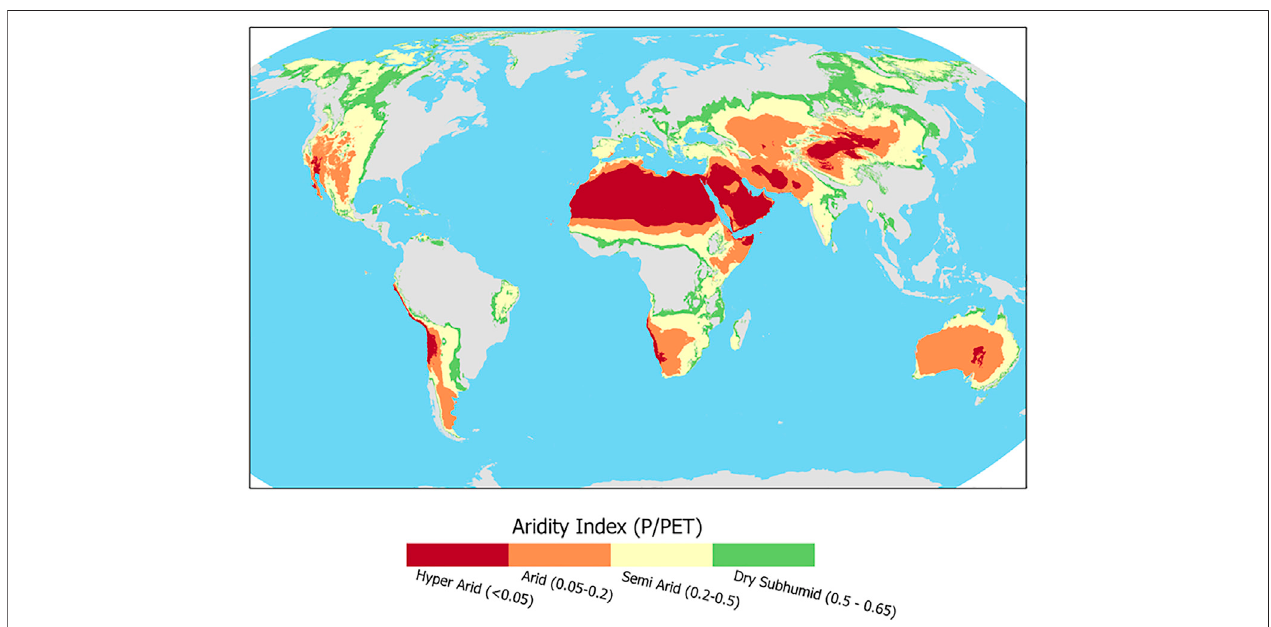
FIGURE1| Location ofthe drylands based on annual precipitation (P)and potential evapotranspiration (PET), with hyper-arid (HA, P/PET < 0.05),arid (A, 0.05 < P/ PET < 0.2), semi-arid (SA, 0.2 < P/PET < 0.5) and dry sub-humid (DS, 0.5 < P/PET < 0.65). Data used to construct this map derived from the Global Aridity and Potential Evapotranspiration (ETO) Climate Database (V2; Trabucco and Zomer, 2019) and the WorldClim historical climate data (V1; Fick and Hijmans, 2017).